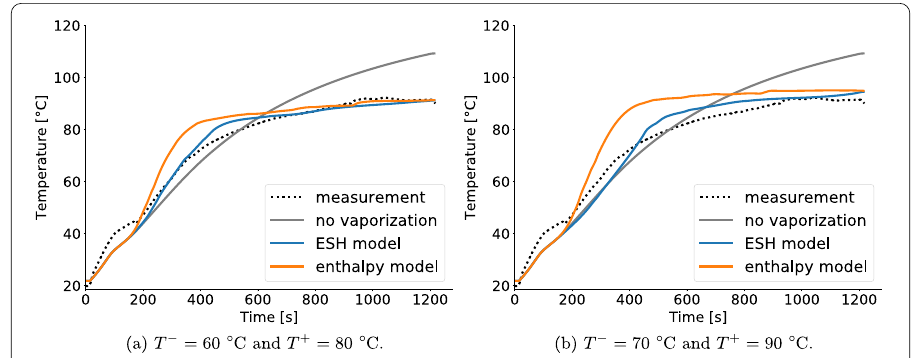
Figure 7 Sensitivities with respect to the choice of the condensation region Ω cond = { x ∈ Ω | T – ≤ T ≤ T + }